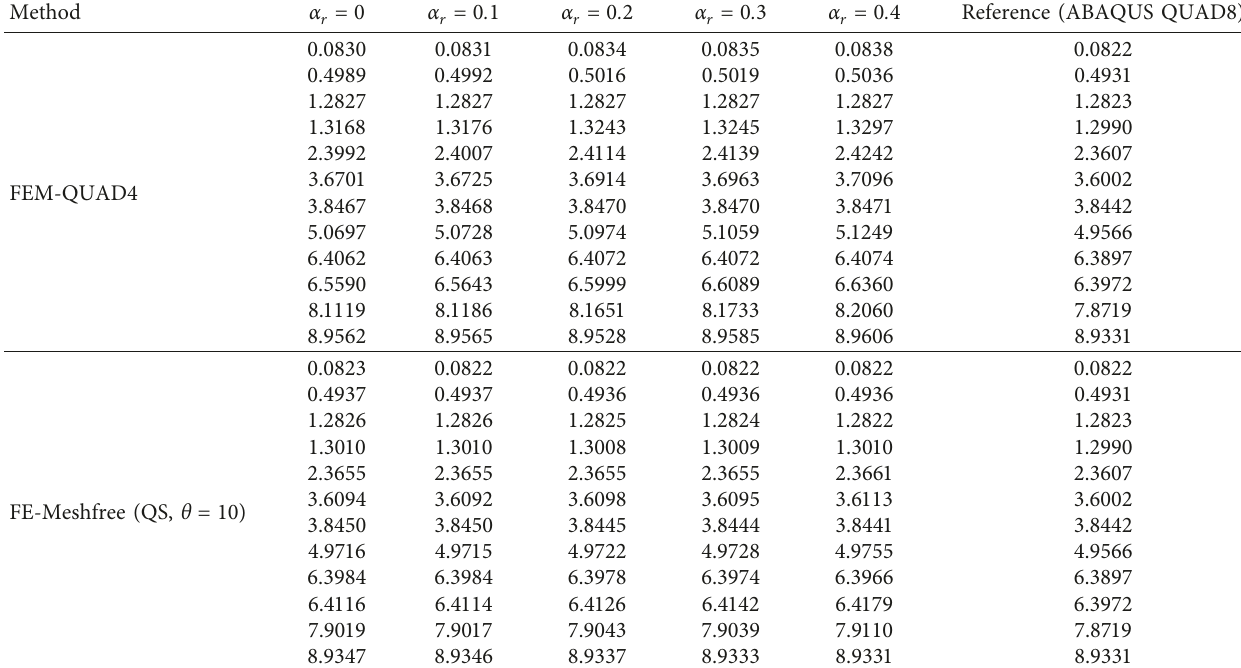
Figure 17: Beam domain discretization using four-node element with irregular elements. (a) α Table 8: First 12 natural frequencies ( × 10 4 Hz) of a cantilever beam using irregular nodal distribution (50 × 5 elements).